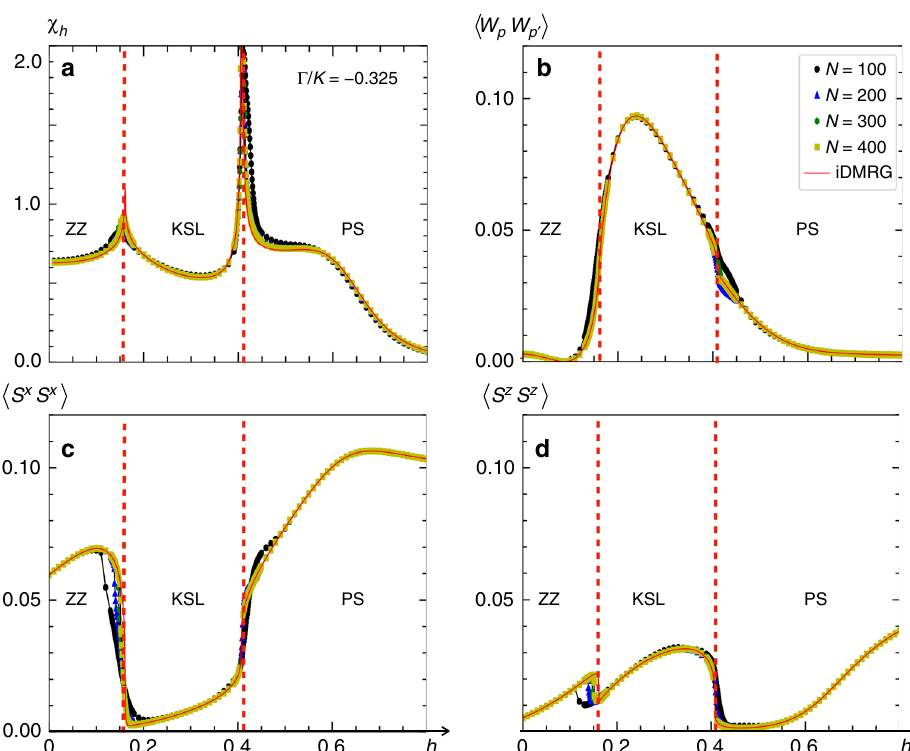
Fig. 5 Evolving correlations in a magnetic fi eld. With Γ / K = − 0.325 and Γ ′ = − 0.1, quantities computed in the two-leg honeycomb strip with DMRG are plotted as a function of a 5° fi eld for system sizes N = 100, 200, 300, 400 and in fi nite DMRG (iDMRG) as solid red line. a χ h displays two peaks which sharpen with increasing system size. These transitions separate ZZ magnetic order and the PS from the intervening KSL. b Plaquette – plaquette correlations (cid:5) (cid:6) W W are small within the ZZ and polarized phases, and become appreciable within the KSL. c Conversely, the xx spin – spin correlations 〈 S x S x 〉 are small p p ′ within the KSL and large in the magnetically ordered phases. d Sharp changes in the zz spin – spin correlations are seen across the phase boundaries, and display a fi nite value consistent with a KSL in fi eld. Spin and plaquette correlations are evaluated at the largest separation accessible in each